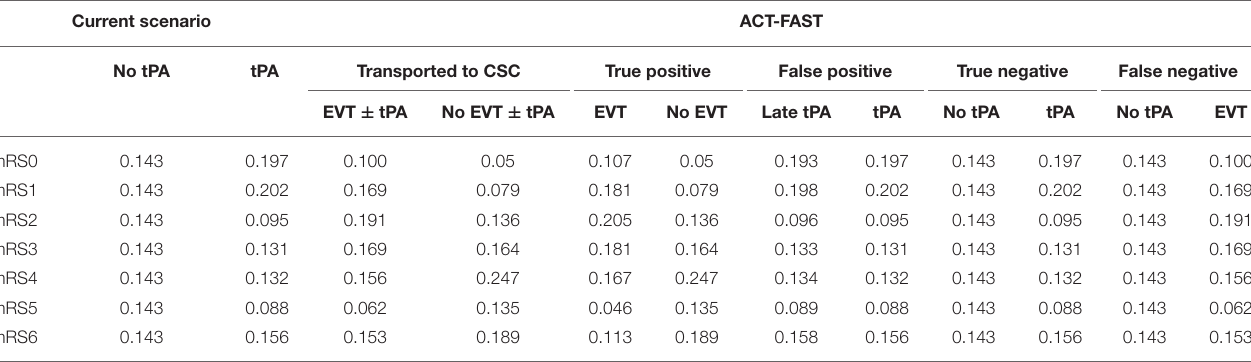
TABLE 2 | Modified Rankin scale outcomes at 3 month by treatment